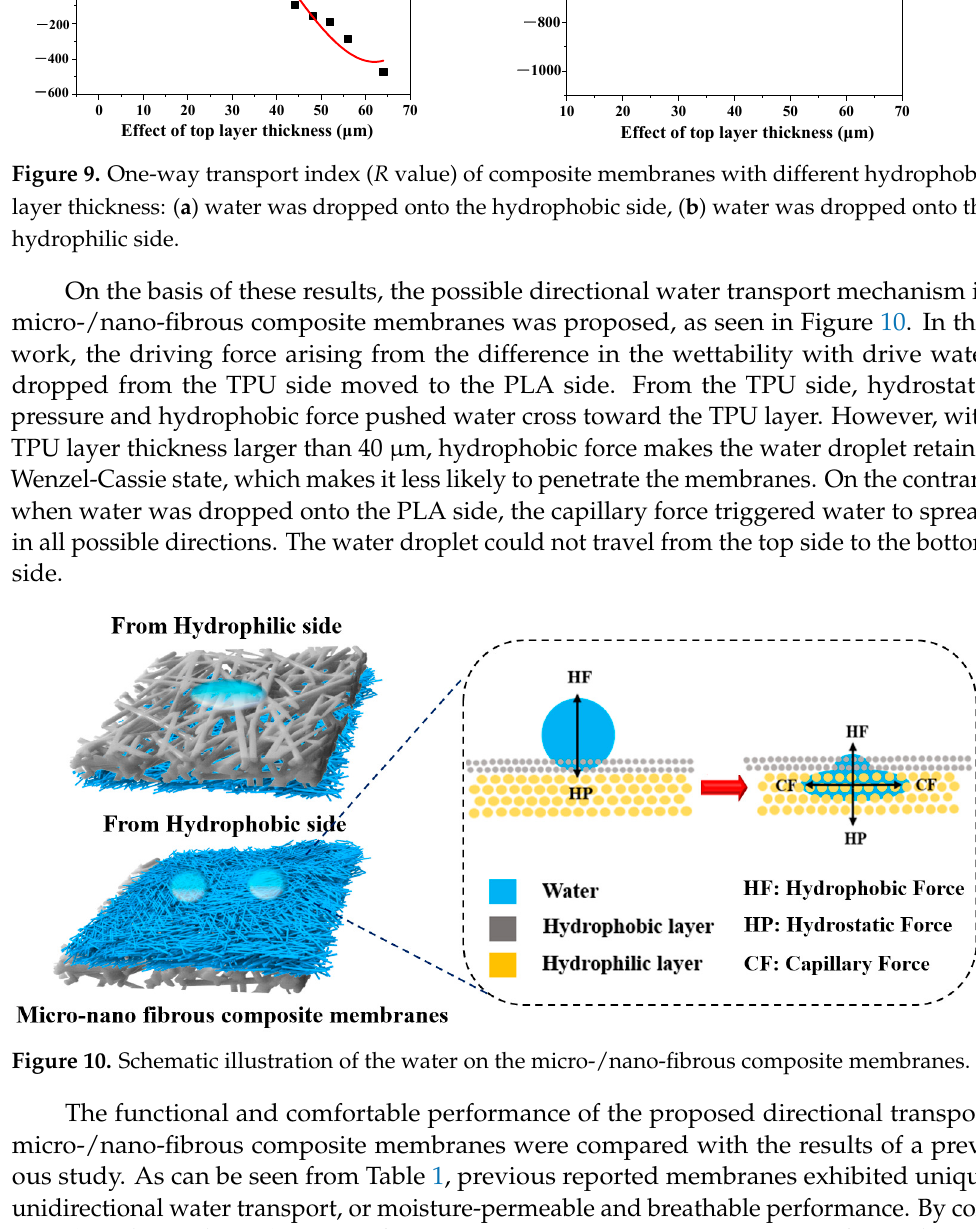
Figure 10. Schematic illustration of the water on the micro-/nano-fibrous composite membranes.